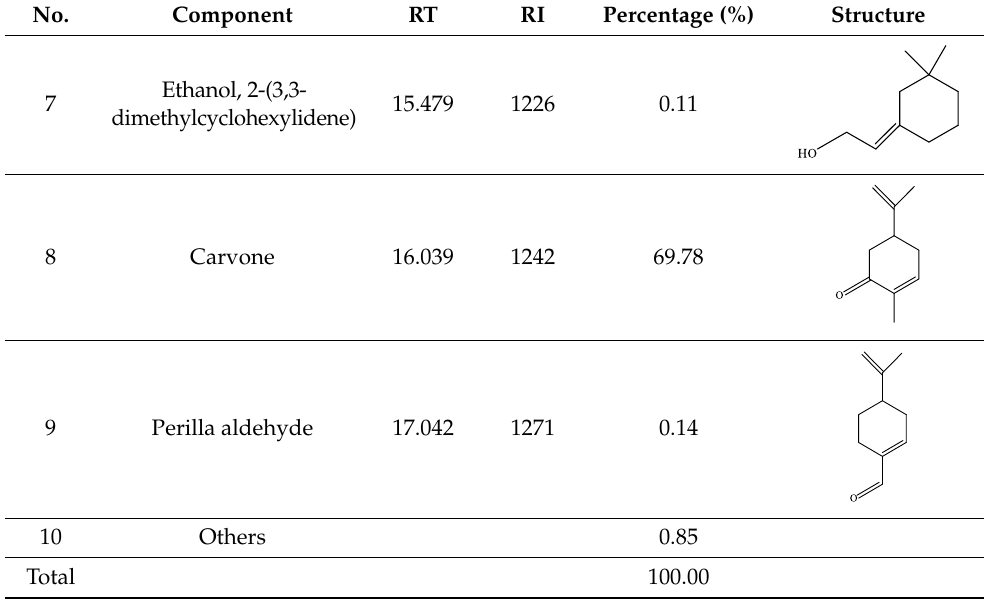
Table 2. Antibacterial activities of CEO.